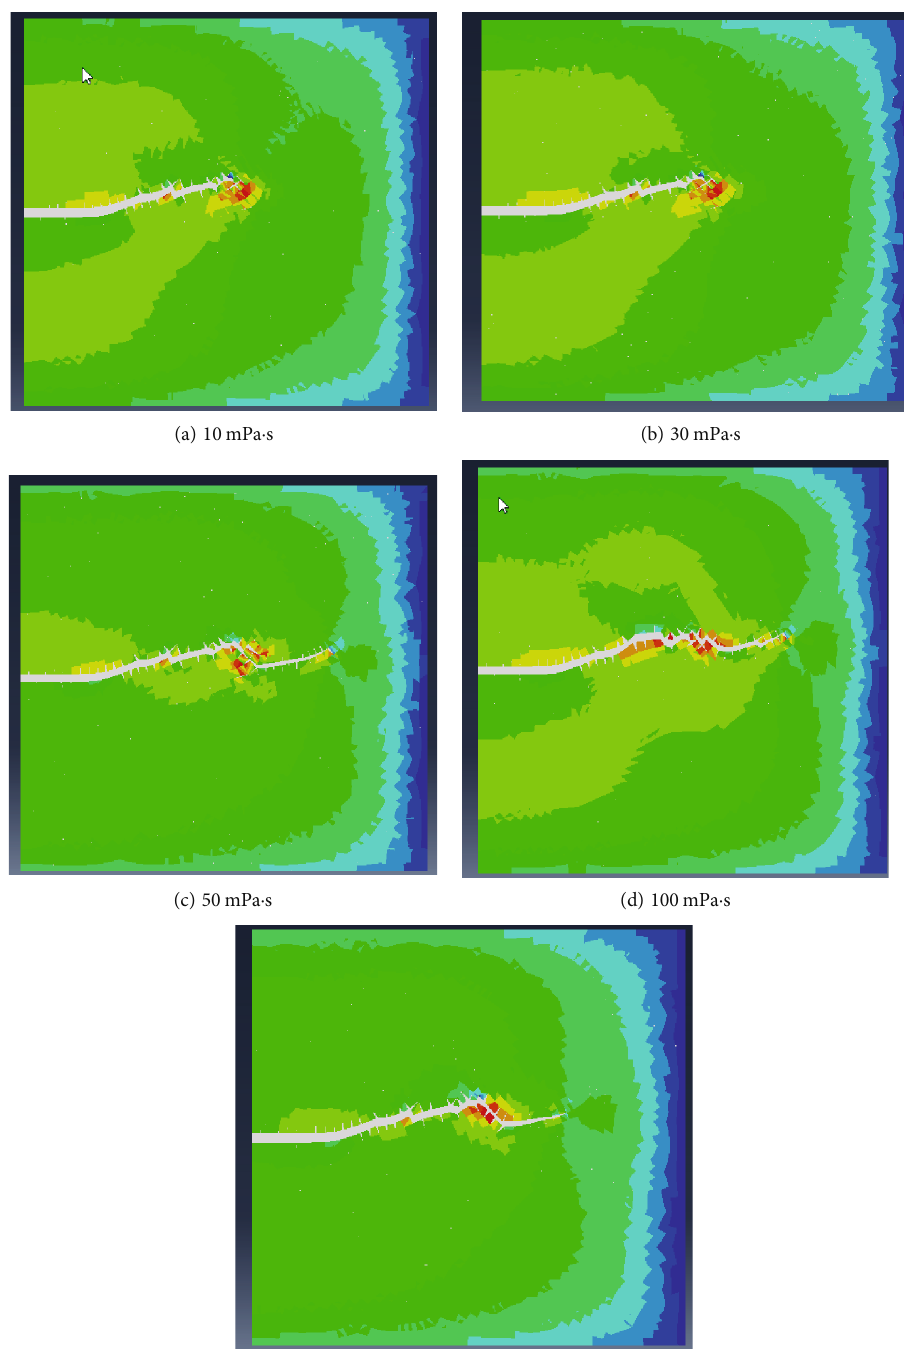
Figure 18: Stress contour map at the NF approaching angle of 30 ° and fl uid viscosity of 10-200 mPa ·